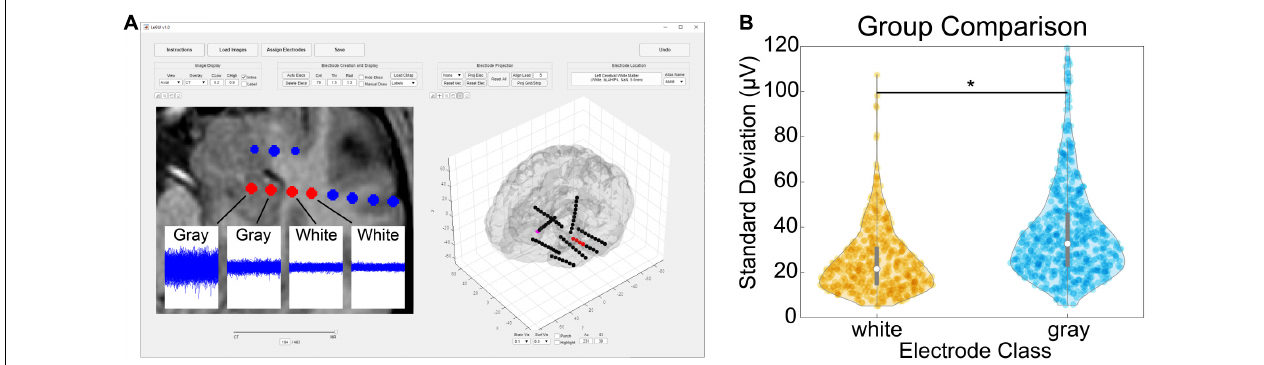
FIGURE 5 | Comparison of gray and white segmentation results using electrophysiology recordings. (A) Patient-specific example showing SEEG electrodes (AdTech BF08R-SP05X-000, 5-mm spacing) in left hippocampus transitioning to white matter (left to right) with corresponding LFP data (1-kHz sampling rate, 0.3-Hz high-pass filter). Each data plot spans 1.5 s along the x-axis and 1.5 mV along the y-axis and displays 415 overlaid time segments distributed throughout an approximately 50-min recording session. Standard deviations from left to right were 95 (gray), 38 (gray), 23 (white), and 21 (white) µ V, respectively. (B) Comparison of recording amplitude (standard deviation) from 17 patients for a total of 1066 gray/white classified electrode contacts (456 white, 610 gray). Gray electrodes recorded higher amplitudes compared with white (pairwise rank sum, p < 0.001). Asterisk indicates